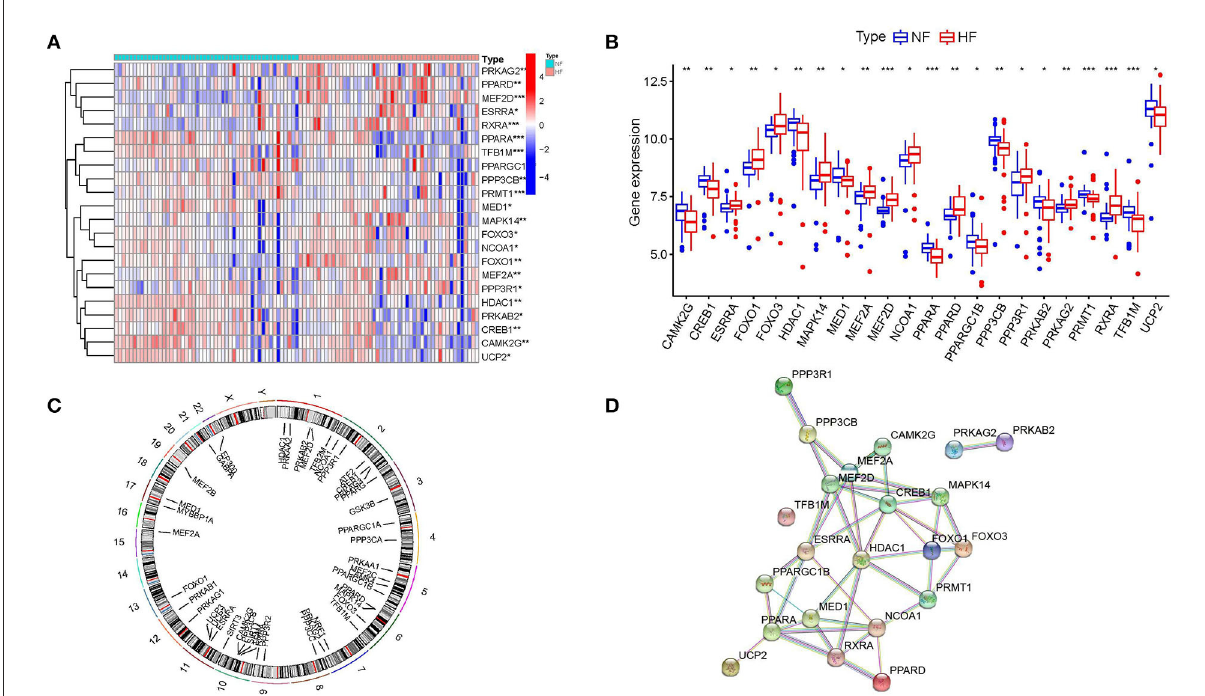
FIGURE1 Identification of differentially expressed energy metabolism-related genes. (A,B) Expressions of differentially expressed energy metabolism-related genes. (C) Circos plot showing the location of genes in 22 chromosomes. (D) Protein-protein interaction networks.